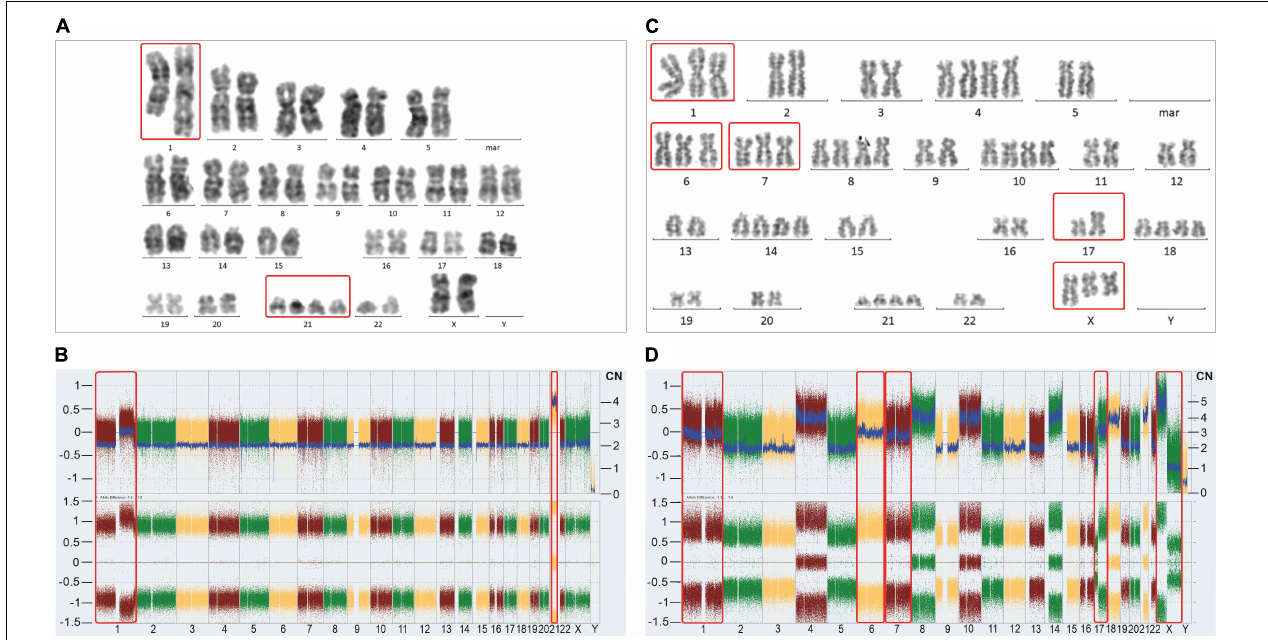
FIGURE 3 | Representative karyotypes (A,C) and SNP/CGH array-derived whole genome views (B,D) of a postulated mononuclear-derived monoclonal (A,B) and a postulated binuclear-derived pure hyperdiploid ALL case (C,D) . Affymetrix Cytoscan HD SNP arrays were processed according to the manufacturer’s recommendation and analyzed with the ChAS Software (Affymetrix, Santa Clara, CA, United States). The weighted log2 ratio, shown in the top (y-axis, left scale) indicates the respective copy numbers (y-axis, right scale) and the allele difference plot in the bottom shows the SNP distribution patterns (y-axis; homozygous AA = 1, heterozygous AB = 0, homozygous BB = − 1). The x-axis indicates the chromosome numbers. Of note, corresponding mono-and biclonal hyperhaploid and hyperdiploid cell populations produce indistinguishable array patterns, so that cytogenetic, DNA-index and/or FISH analyses are required to keep them